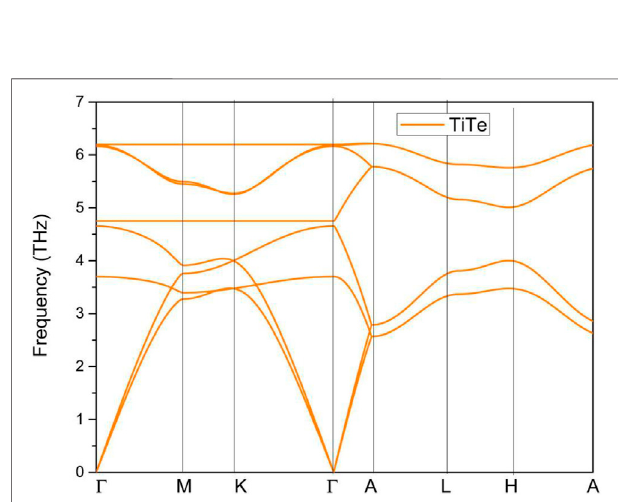
FIGURE 2 | (A,B) Structural models. (C) The bulk and the (001) surface Brillouin